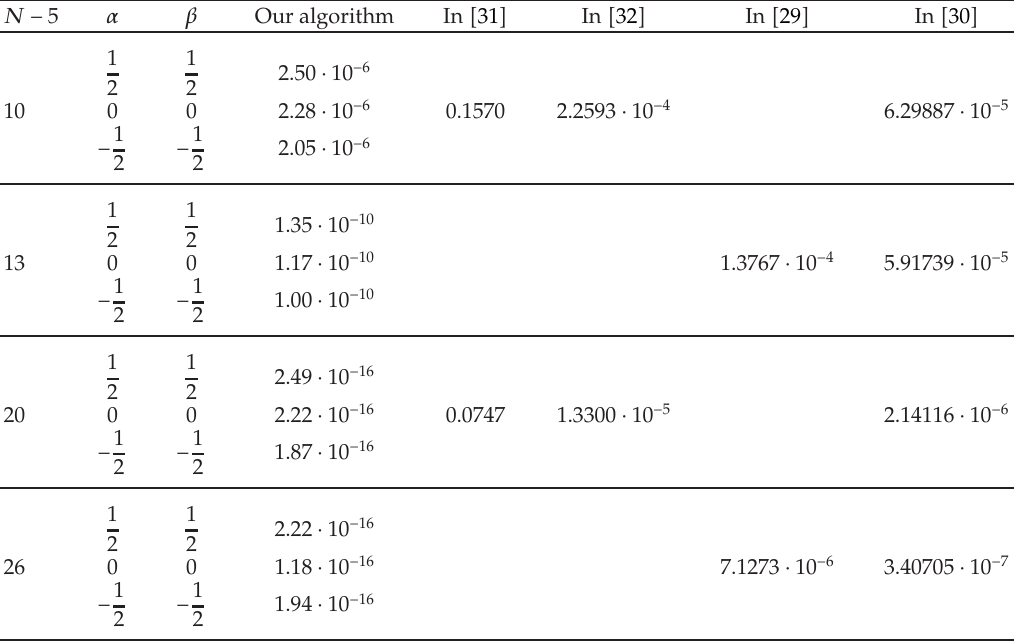
Table 3: Maximum pointwise error of u − u N − 5 α β Our